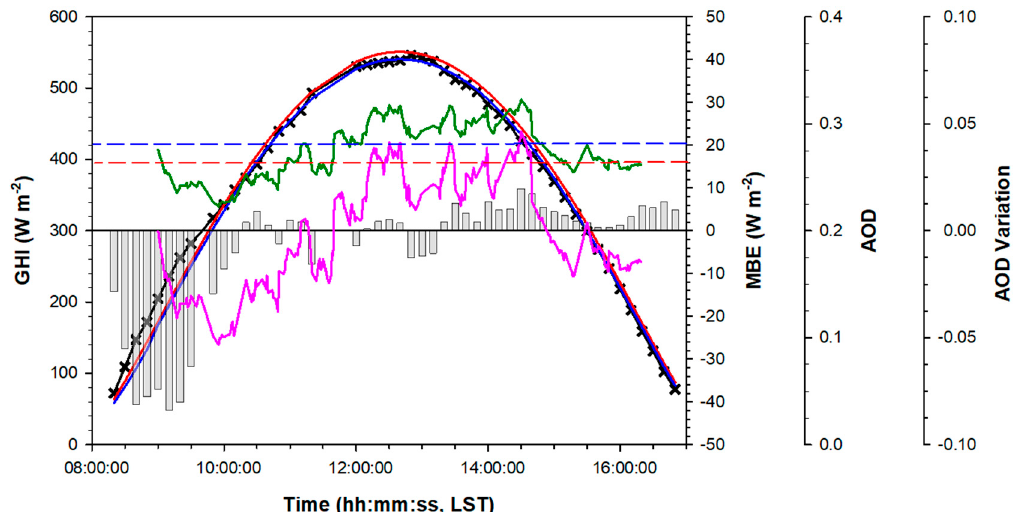
Figure 9. Time series of global horizontal irradiance (GHI), aerosol optical depth (green line), and variability in aerosol optical depth (pink line) at the Korea Institute of Energy Research (KIER) station on 14 January 2021. The black solid line with crosses, blue solid line, and red solid line indicate the GHI observation, GHI estimate from the control run, and GHI estimate from the S1 run, respectively. The vertical bar indicates the mean bias error between GHI observation and estimates from the control run. Blue and red dashed lines indicate the monthly mean and daily mean of aerosol optical depth employed in the simulation, respectively.